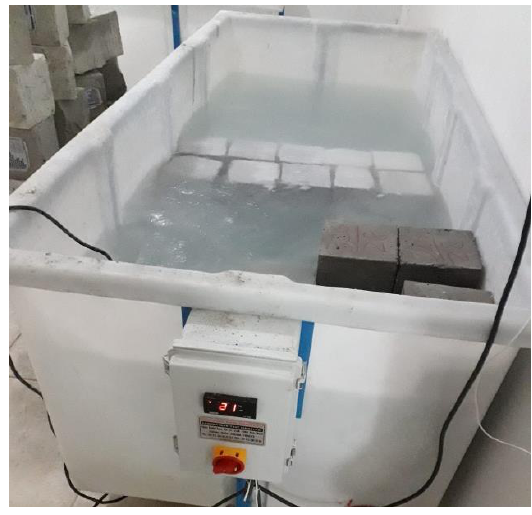
Figure 8. Curing pool.